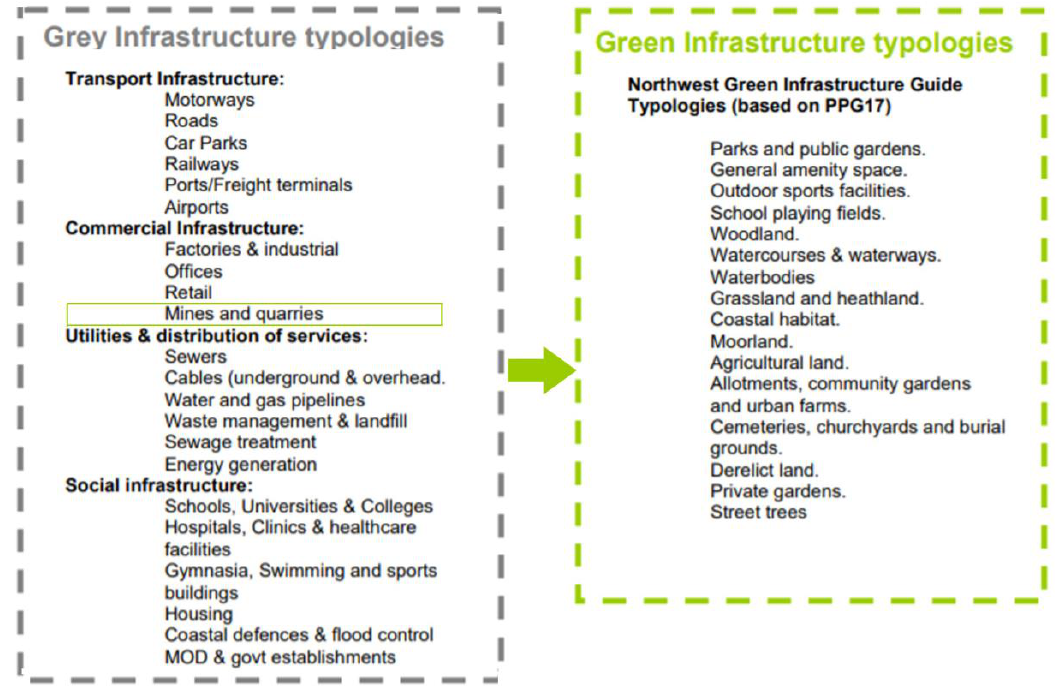
Figure 2. Component parts of Grey and Green Infrastructures. (Source: NENW, 2009 [22]) .